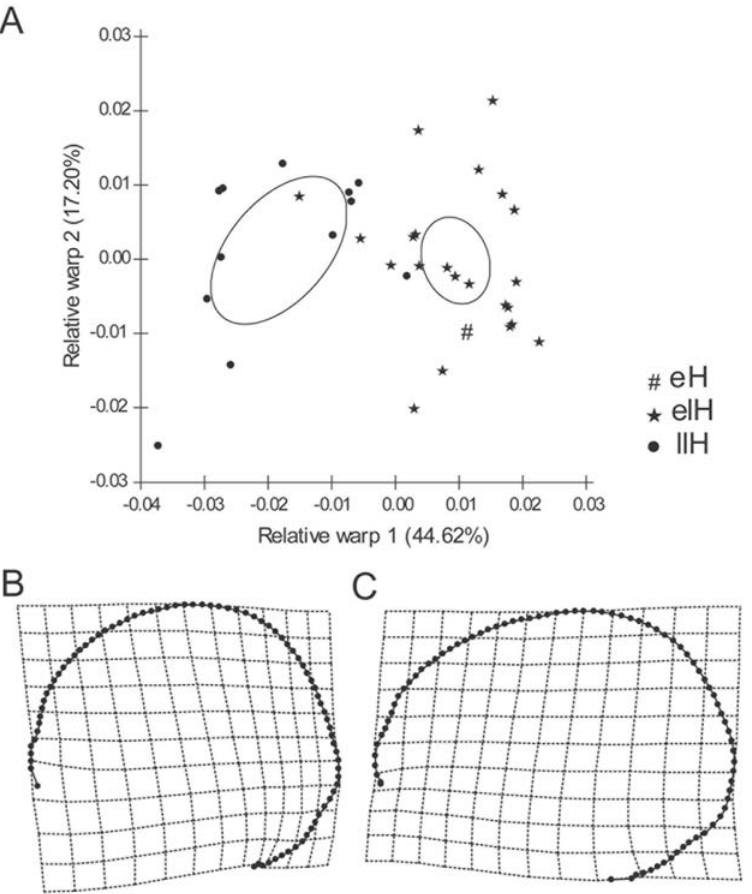
Figure 5. Relative Warp analysis of the cranial vault. A) Ordination of the individuals from East Central samples in the space of the first two relative warps, based on the partial warp and uniform component variables calculated for the vault. The circles ( $ ) represent the individuals for Later Late Holocene sample (llH), stars ( w ) represent the individuals for each Earlier Late Holocene sample (elH), and number sign ( # ) represents the individual for the Early Holocene sample from Arroyo Seco 2 (eH). The ellipses are the 95% confidence intervals of Earlier and Later Late Holocene mean samples. B and C) Vault shape changes implied by variation along the first relative warp axis is shown as deformation grids. Grids show shape changes for negative (B) and positive (C) deviations from the mean for RW1.